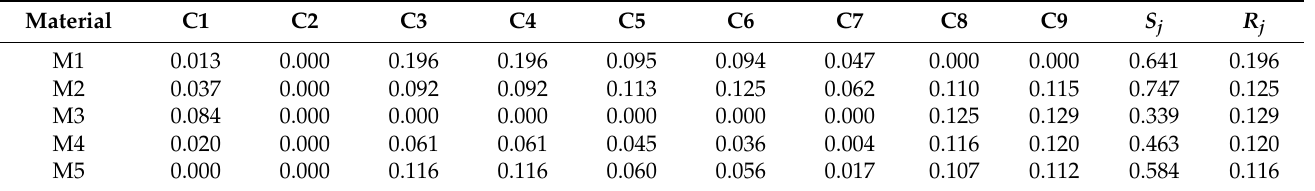
Table 9. VIKOR calculations.